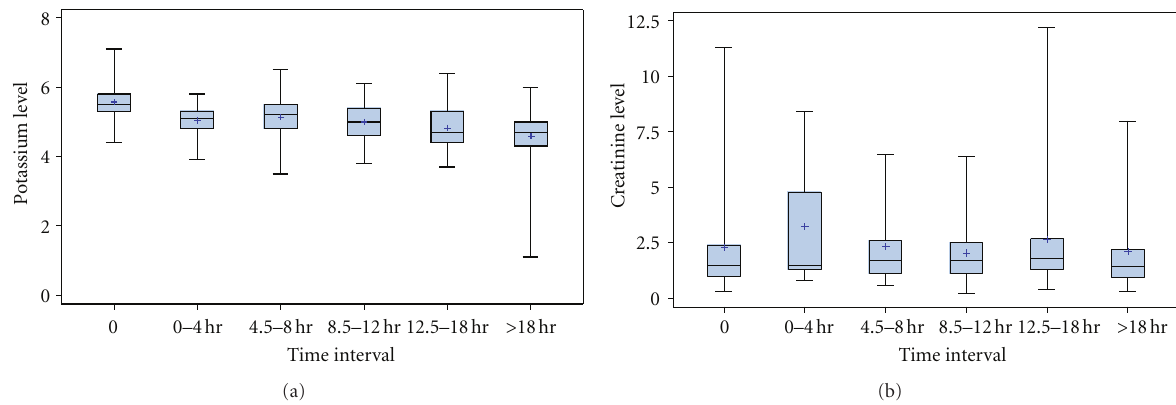
Figure 2: (a) The serum potassium values in mmol/L at the various time intervals. (b) The serum creatinine values in mg/dL at the various time intervals.